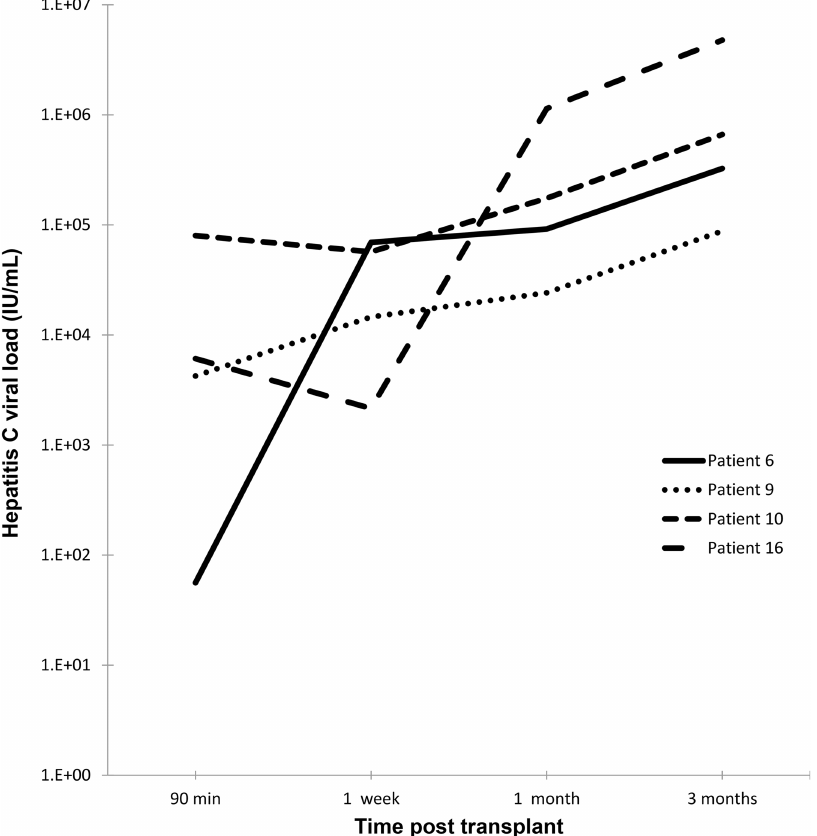
Fig 4. Examples of HCV recurrencein patient serum after liver transplantation. Each line represents an individual patient’s serum HCV viral load over the 3 months followingtransplantation.